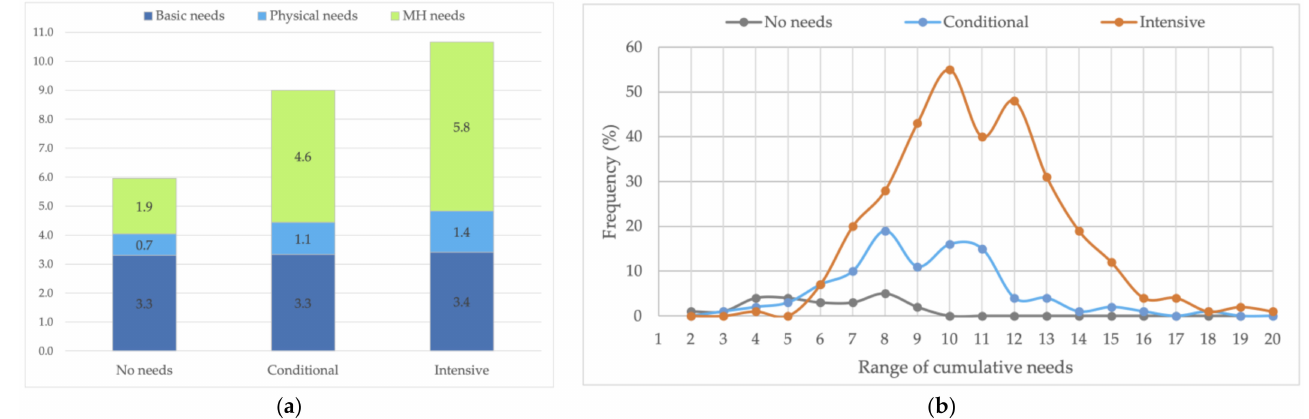
Figure 2. Cumulative needs by subgroup. ( a ) Means and composition. ( b ) Frequency